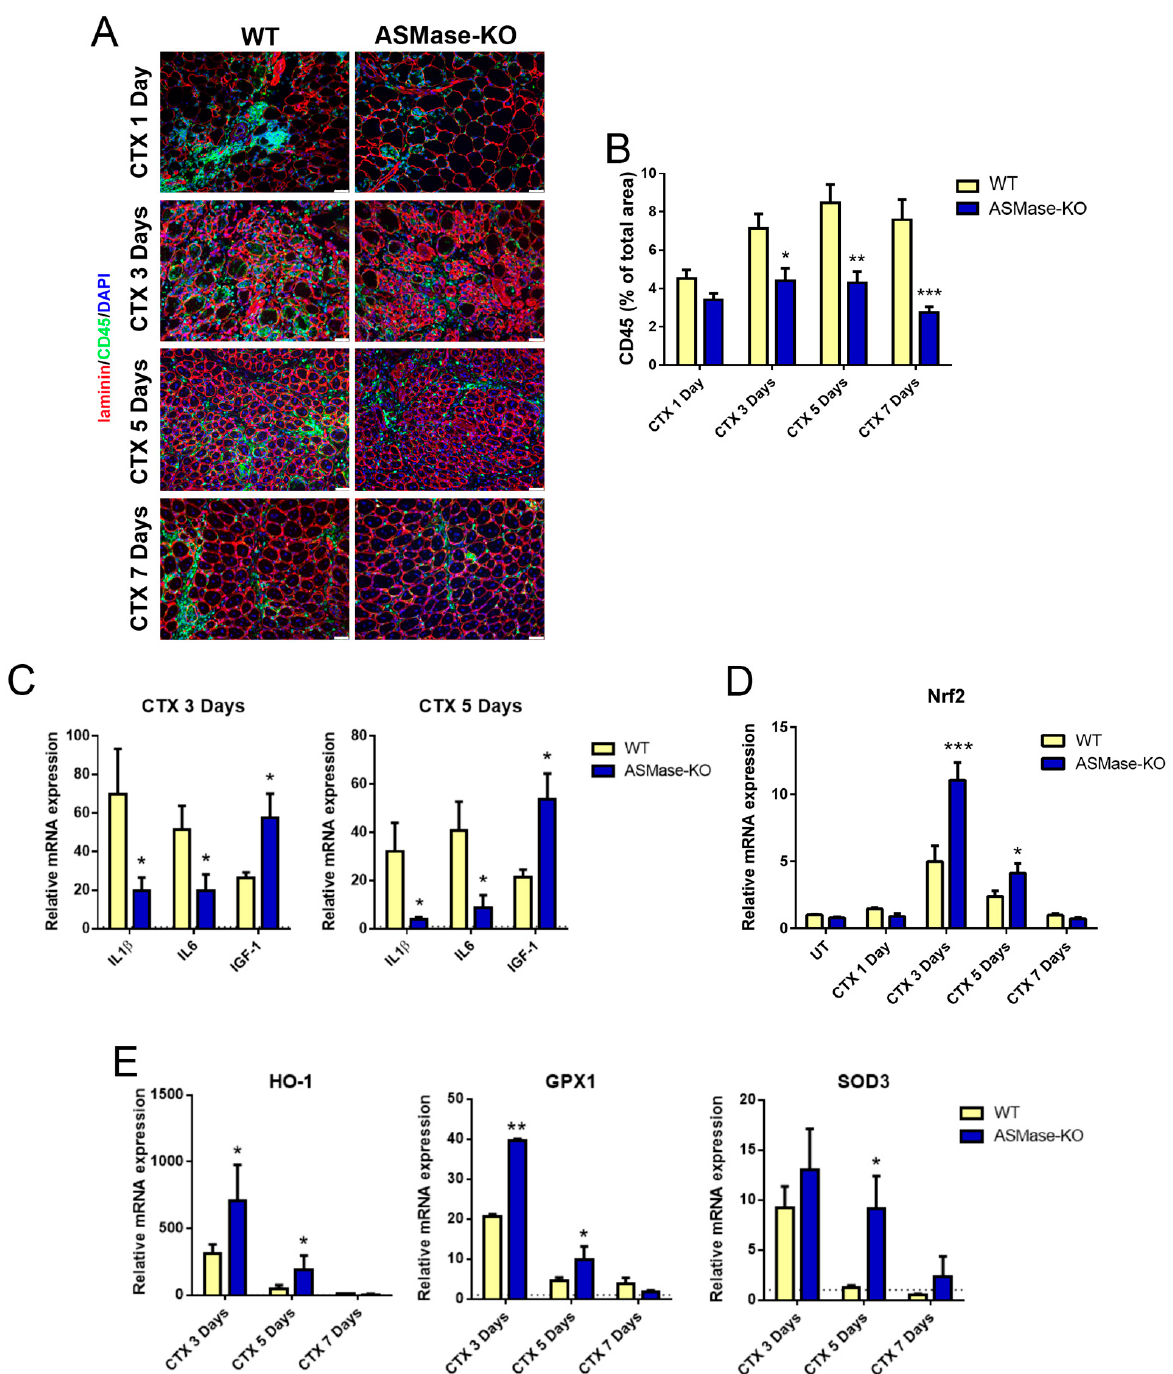
Figure 4. ASMase in inflammation in injured muscle. ( A ) Representative images of CD45 immunostaining and DAPI nuclear counterstaining (blue) of transverse sections from WT and ASMase-KO TA muscles at different time points after CTX injection. ( B ) CD45 positive (CD45+) quantification. Values are expressed as mean ± SEM ( n = 3 mice). * p < 0.05, ** p < 0.01, *** p < 0.001 vs. the respective WT. ( C ) RT-qPCR analysis of inflammatory markers IL1 β , IL6 and IGF-1 at 3 (left graph) and 5 (right graph) days after CTX injection. Values are expressed as mean ± SEM ( n ≥ 4 mice) normalized vs. the untreated controls (dashed line). * p < 0.05 vs. the respective WT. ( D ) RT-qPCR analysis of Nrf2 at different time points after CTX injection. Values are expressed as mean ± SEM ( n ≥ 3 mice) normalized vs the untreated control. * p < 0.05, *** p < 0.001 vs. the respective WT control. UT: untreated ( E ) RT-qPCR analysis of HO-1, GPX1 and SOD3 at different time points after CTX injection. Values are expressed as mean ± SEM ( n ≥ 3 mice) normalized vs. the untreated controls (dashed line). * p < 0.05, ** p < 0.01 vs. the respective WT.